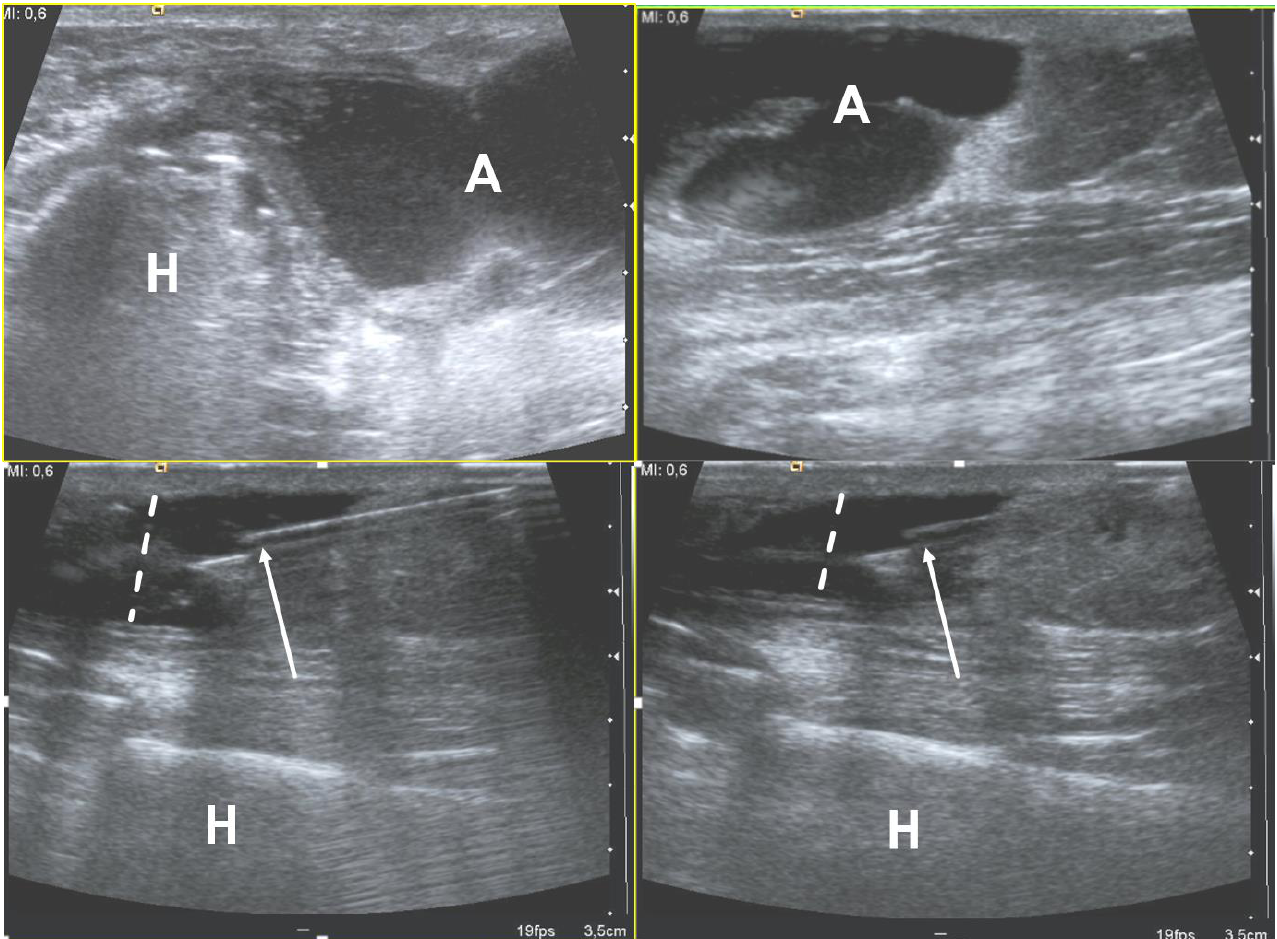
Figure 2. Ultrasound examination of a soft-tissue abscess of lateral aspect of the left harm in a patient who were recently operated for humeral fracture. The needle’s tip is placed inside the abscess (arrows) under ultrasound guidance (in-plane approach); during the fluid aspiration, the reduction of the abscess can be appreciated (dotted lines). H = humerus, A = abscess.